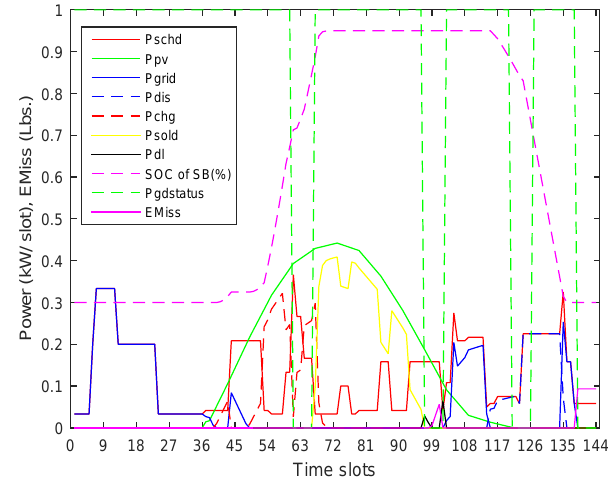
Figure 9. Power and emission profiles for DRSREODLDG-based HEMS operation for